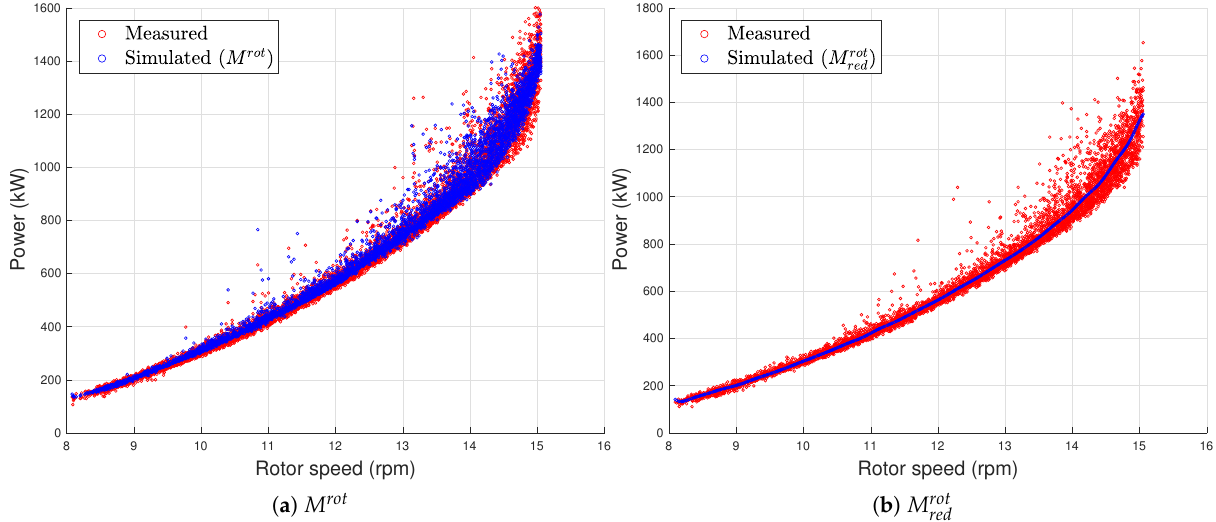
Figure 7. Measured and simulated rotor speed-power curves: D2 data set, T1 wind turbine. M rot model on the left, M rot the